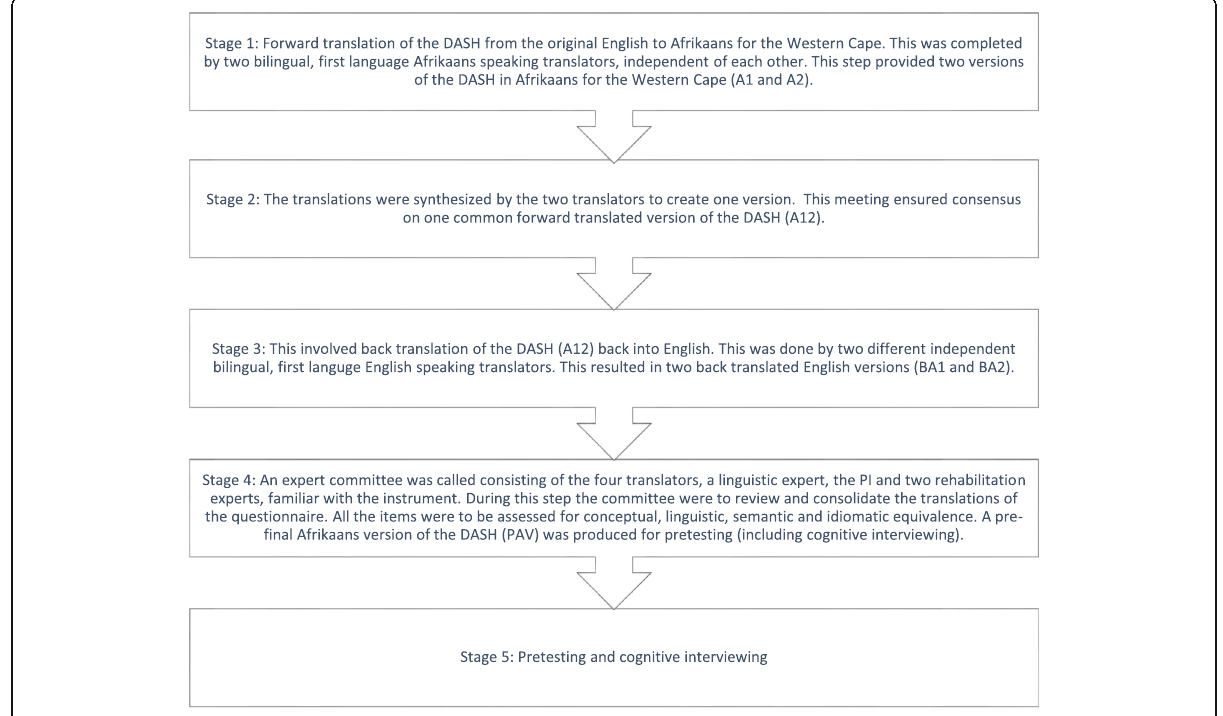
Fig. 1 Stages of translation and cross-cultural adaptation recommended for approval of a translated version of the DASH by the